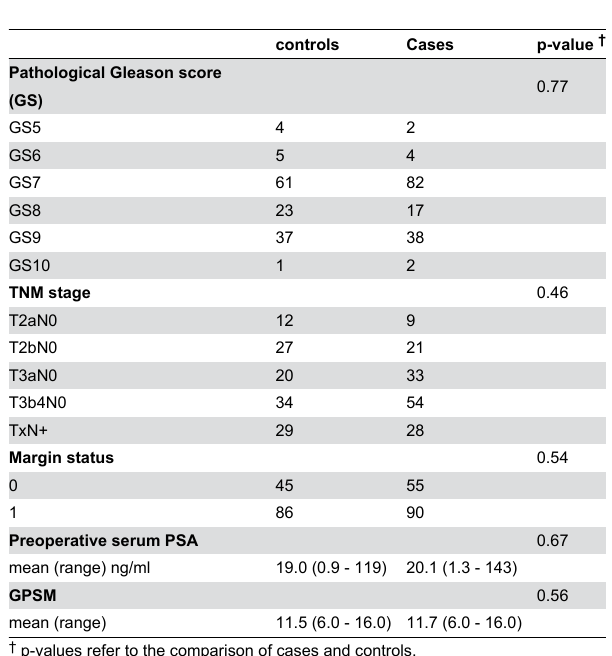
Table 1. Clinical parameter values in cases and controls.